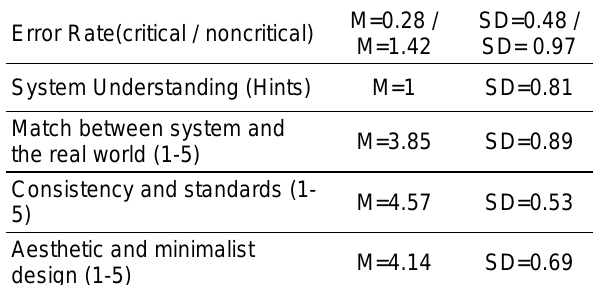
Table 3. Subjective measurements